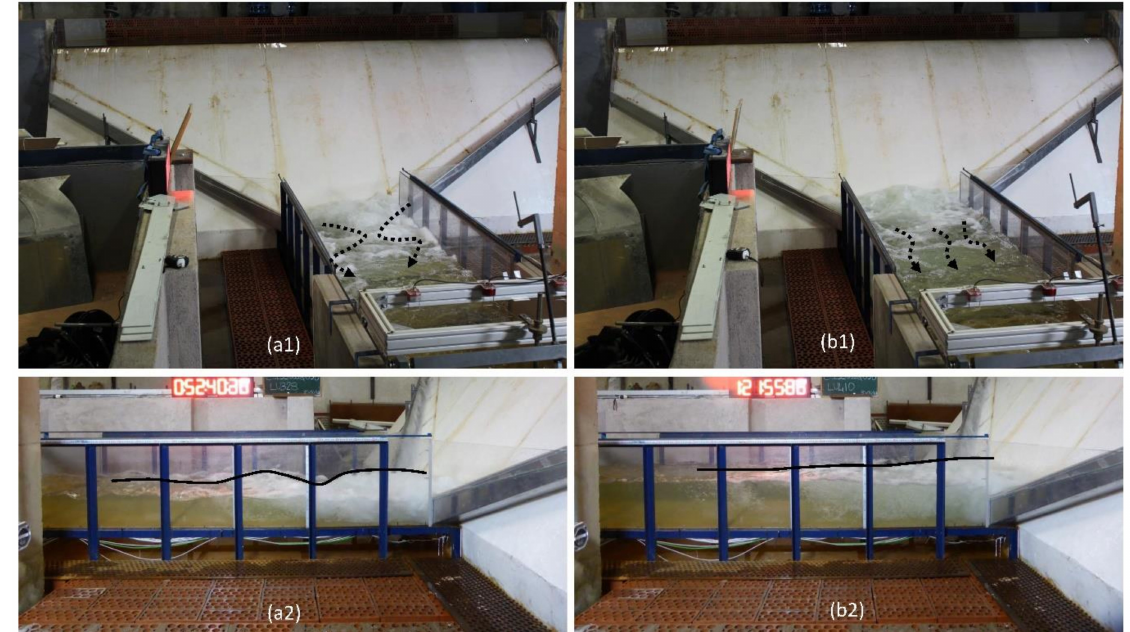
Figure 11. Pictures showing the hydraulic conditions in a stilling basin with low (( a1 , a2 ), views from downstream and left side, respectively) and high submergence (( b1 , b2 ), same positions as a1 and a2, respectively) due to different tailwater elevations in the test with Q T = 0.050 m 3 s − 1 , α = 28 ◦ (configuration B ), P = 0, and K Q =